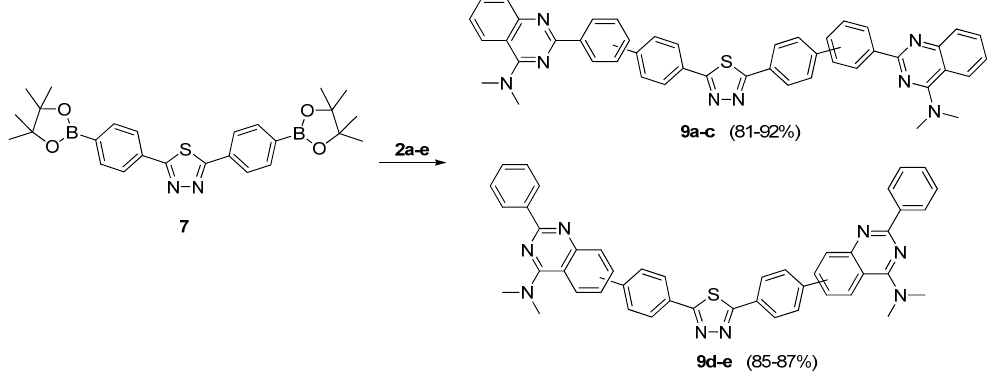
Scheme 7. Suzuki cross-coupling reactions of quinazoline derivatives ( 2a–e ) with bis boronic ester 7 . Reagents and conditions: quinazoline derivative 2a–e (0.82 mmol), boronic acid pinacol ester 7